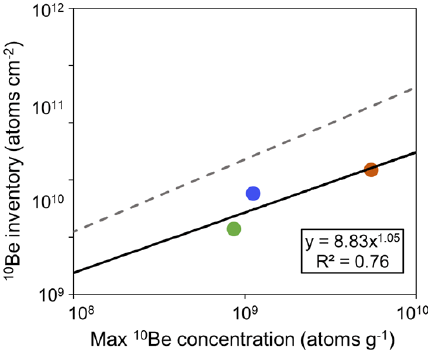
Figure 7. Relationship between the measured maximum (or sur- face) meteoric 10 Be concentration and the calculated inventory (Eq. 2). This relationship is used to infer 10 Be inventories given a maximum or surface concentration (Graly et al., 2010). The solid black line is the power relationship between concentration and in- ventory, while the dashed grey line is the regression from Graly et al.